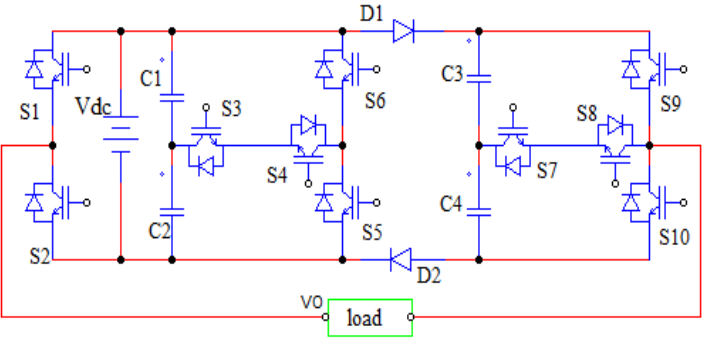
Figure 15. Ten-switch, nine-level topology [64] .